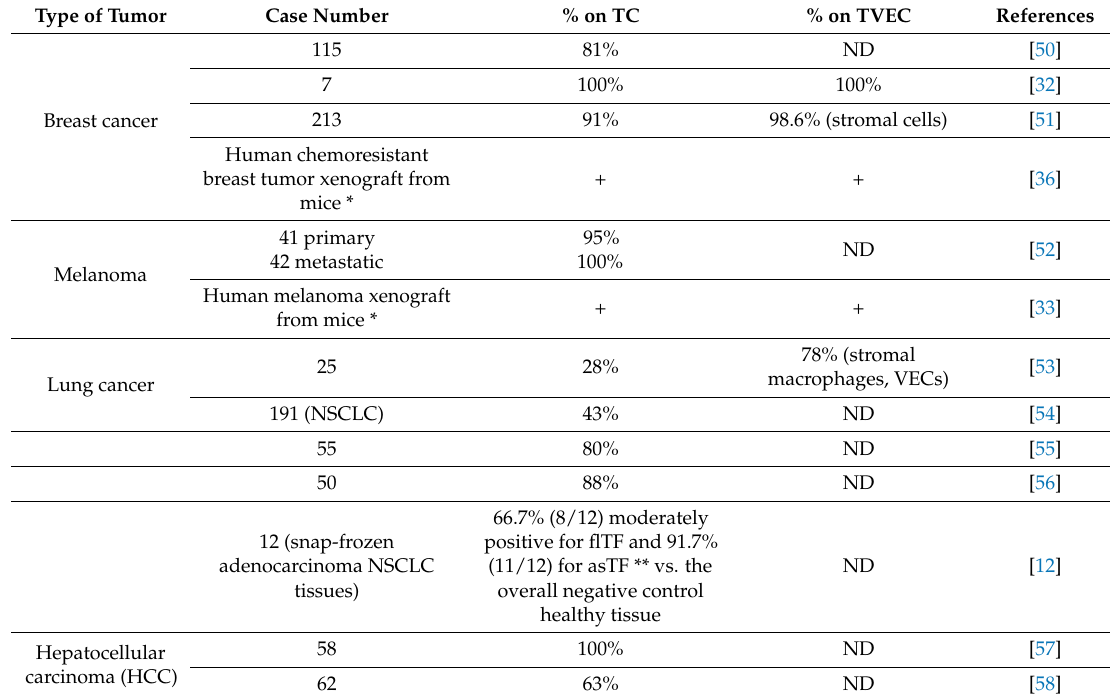
Table 1. Tissue factor expression in solid cancers, leukemia and